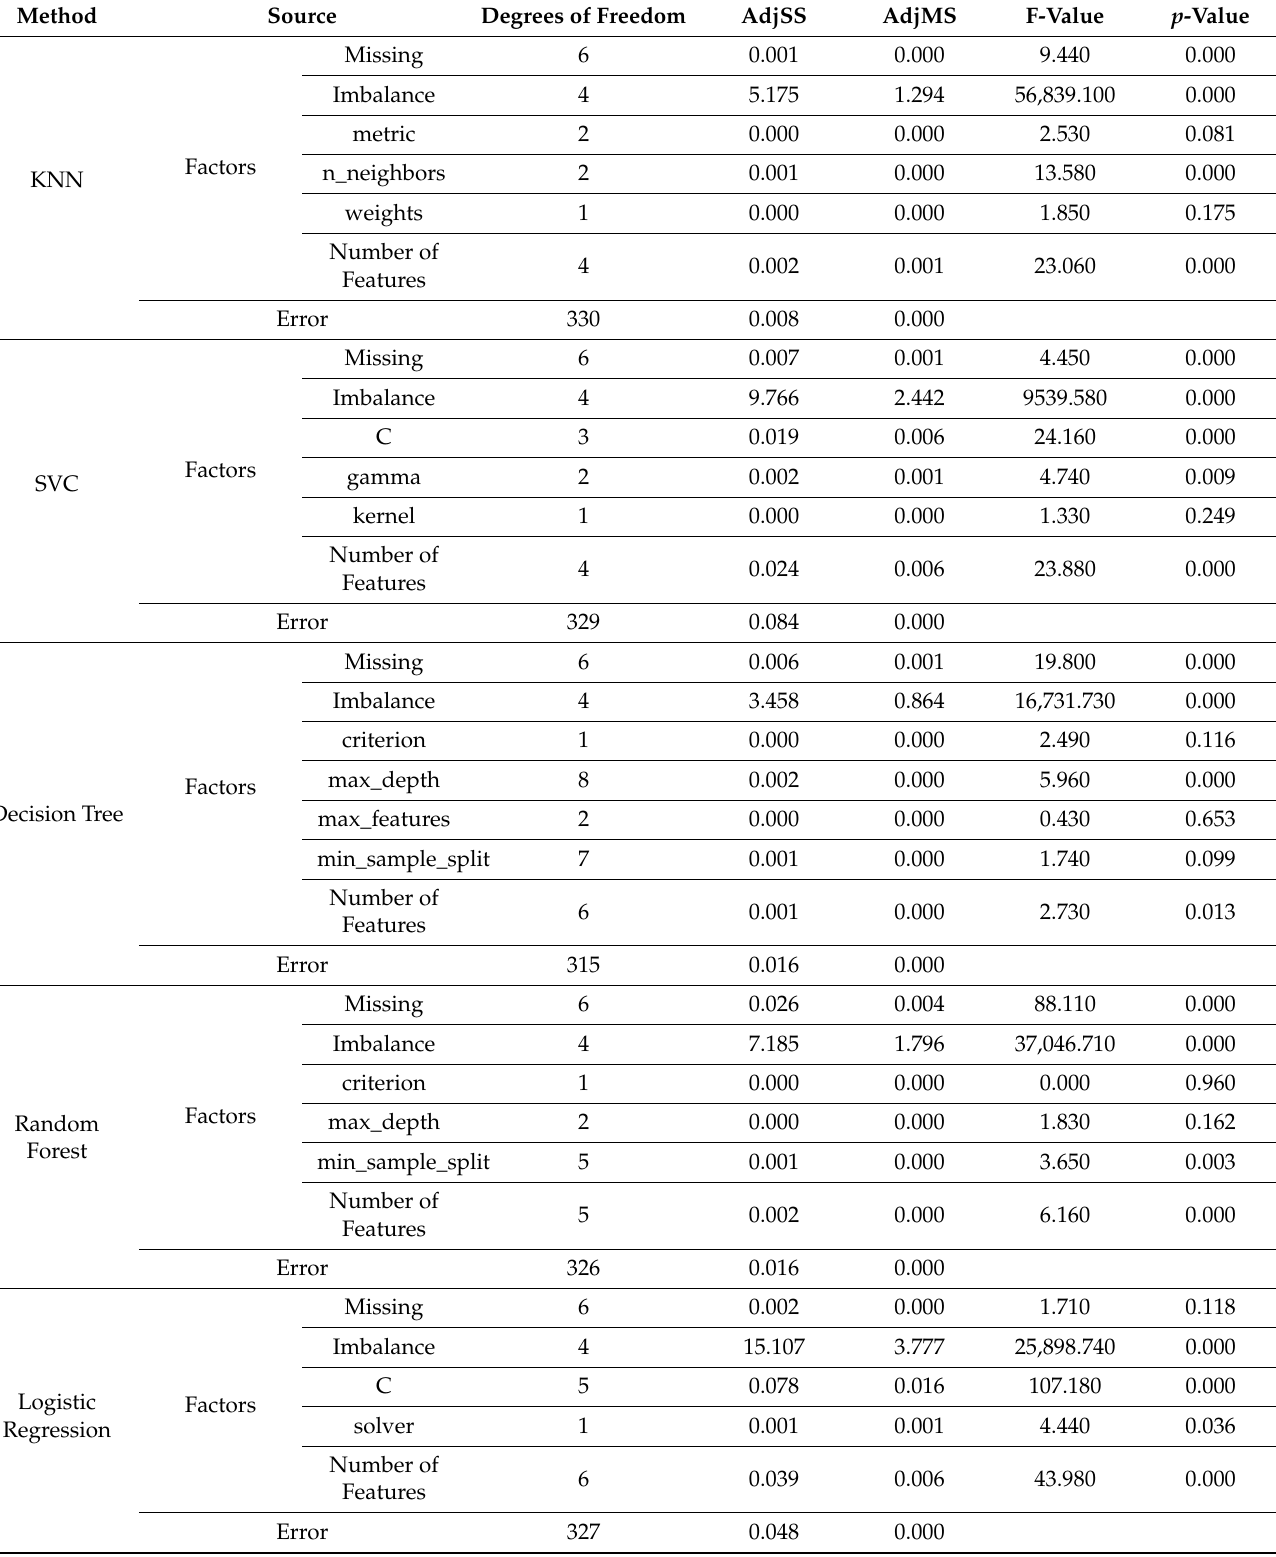
Table 8. Result of ANOVA for F1 scores for each method and its